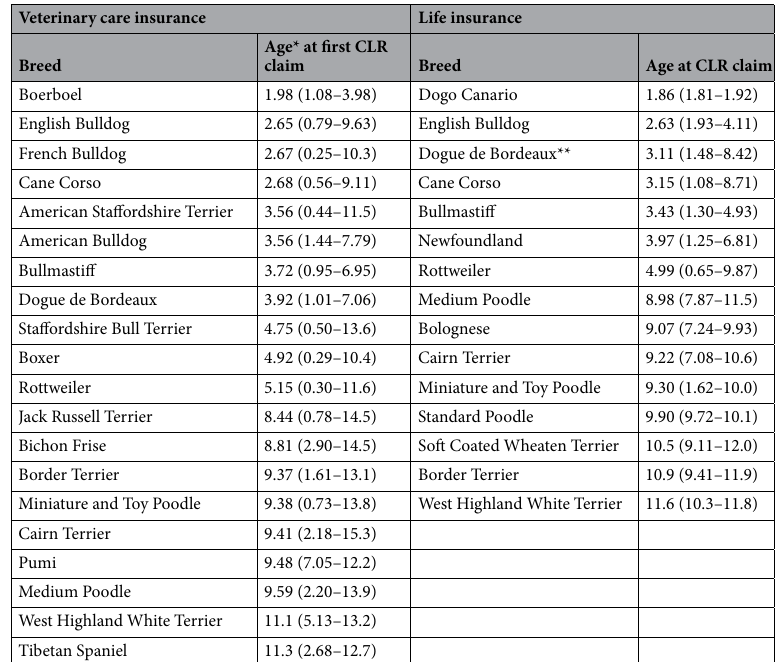
Table 2. Median age in years (range) at first veterinary care claim for cruciate ligament rupture (CLR) or at life insurance settlement due to CLR during the observation period (2011–2016) in a cohort of insured Swedish dogs. *The median age at veterinary care claim for CLR in the listed breeds differed significantly from the median age in all other breeds after Bonferroni correction (based on the number of breeds included in the comparison, n = 181). For a full list of breeds with significantly higher/lower median age at veterinary care claim without Bonferroni correction, see supplementary Table 2. **The only breed with median age at CLR life insurance settlement that differed significantly from the median age of all other breeds, after Bonferroni correction (based on the number of breeds included in the comparison, n = 99). The other listed breeds had a median age at life claim that differed significantly from the median of all other breeds, without Bonferroni correction.